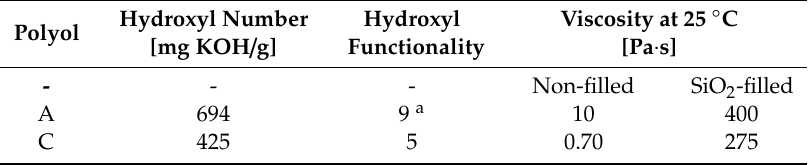
Table 1. Selected physical and chemical properties of the studied polyols.